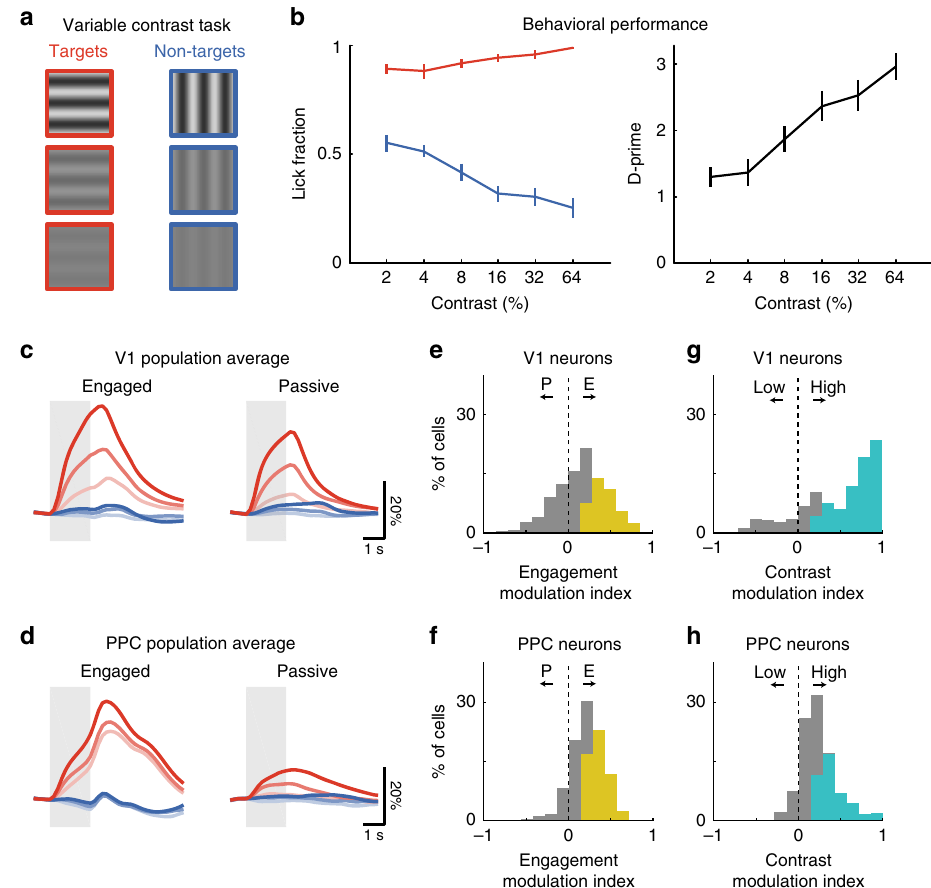
Fig 5 PPC re fl ects both stimulus contrast and behavioral state. a Mice discriminated between orthogonally oriented Target and Non-target stimuli with contrast varying from 2 to 64%. b Behavioral performance (d-prime) on the variable contrast discrimination task, averaged across 19 sessions from 6 mice. Error bars indicate SEM. c Population trial-averaged response of all target-preferring V1 neurons ( n = 250) across contrasts during correct Engaged (left) and Passive (right) target (red) and nontarget (blue) trials. Responses are averaged across low (2 or 4%, light shade), medium (8 or 16%, medium shade), and high (32 or 64%, dark shade) contrast. Light gray shaded regions demarcate duration of stimulus. d Same as c but for PPC ( n = 611 target-preferring neurons). e , f Histograms comparing engagement modulation in V1 ( e ) and PPC ( f ), computed by comparing responses on Engaged vs. Passive high contrast trials. Colored bars indicate neurons with signi fi cant modulation. g , h Histograms comparing contrast modulation in V1 ( g ) and PPC ( h ), computed by comparing responses on high vs. low contrast Engaged trials. Colored bars indicate neurons with signi fi cant